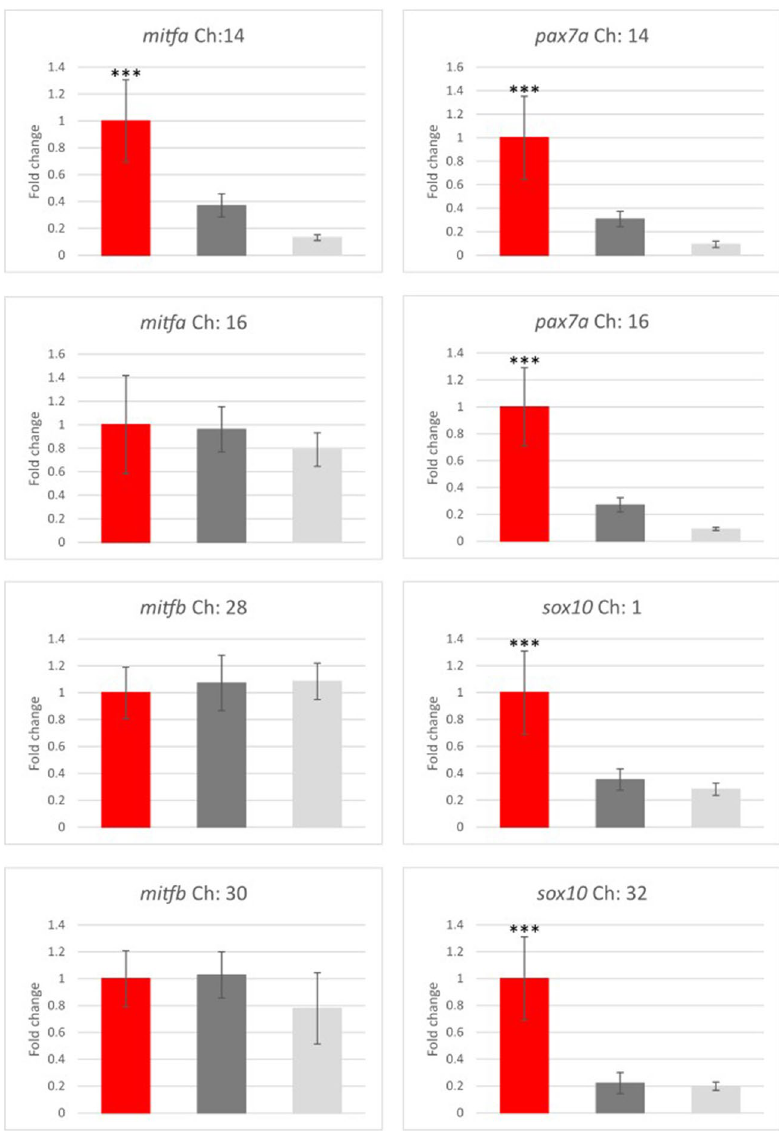
Figure 7. Paralogue gene expression patterns obtained with qPCR. The location of the paralogue gene copy is marked next to the gene name as chromosome number (Ch). Fold changes are expressed as the ratio of gene expression after normalisation to the reference genes. The error bars represent the mean ± SE, and the bars are coloured in red (red spots), dark grey (black spots), and light grey (background colour regions). The expression of each gene was compared with its expression in the red spots and statistically evaluated using the unpaired Student’s t-test. ***p <